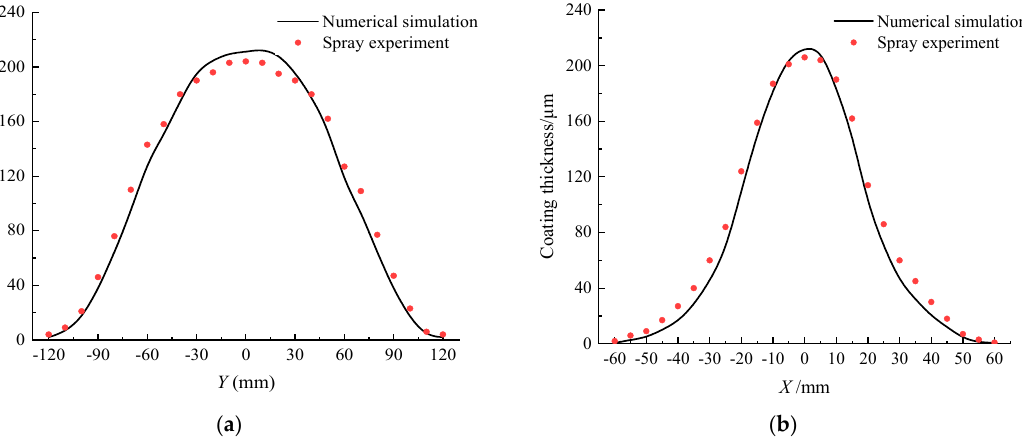
Figure 8. The flow chart of film thickness comparison between numerical simulation and spraying experiment.